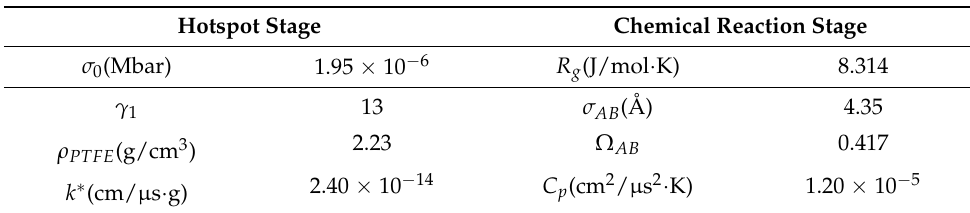
Table 1. Material model parameters for RMs.